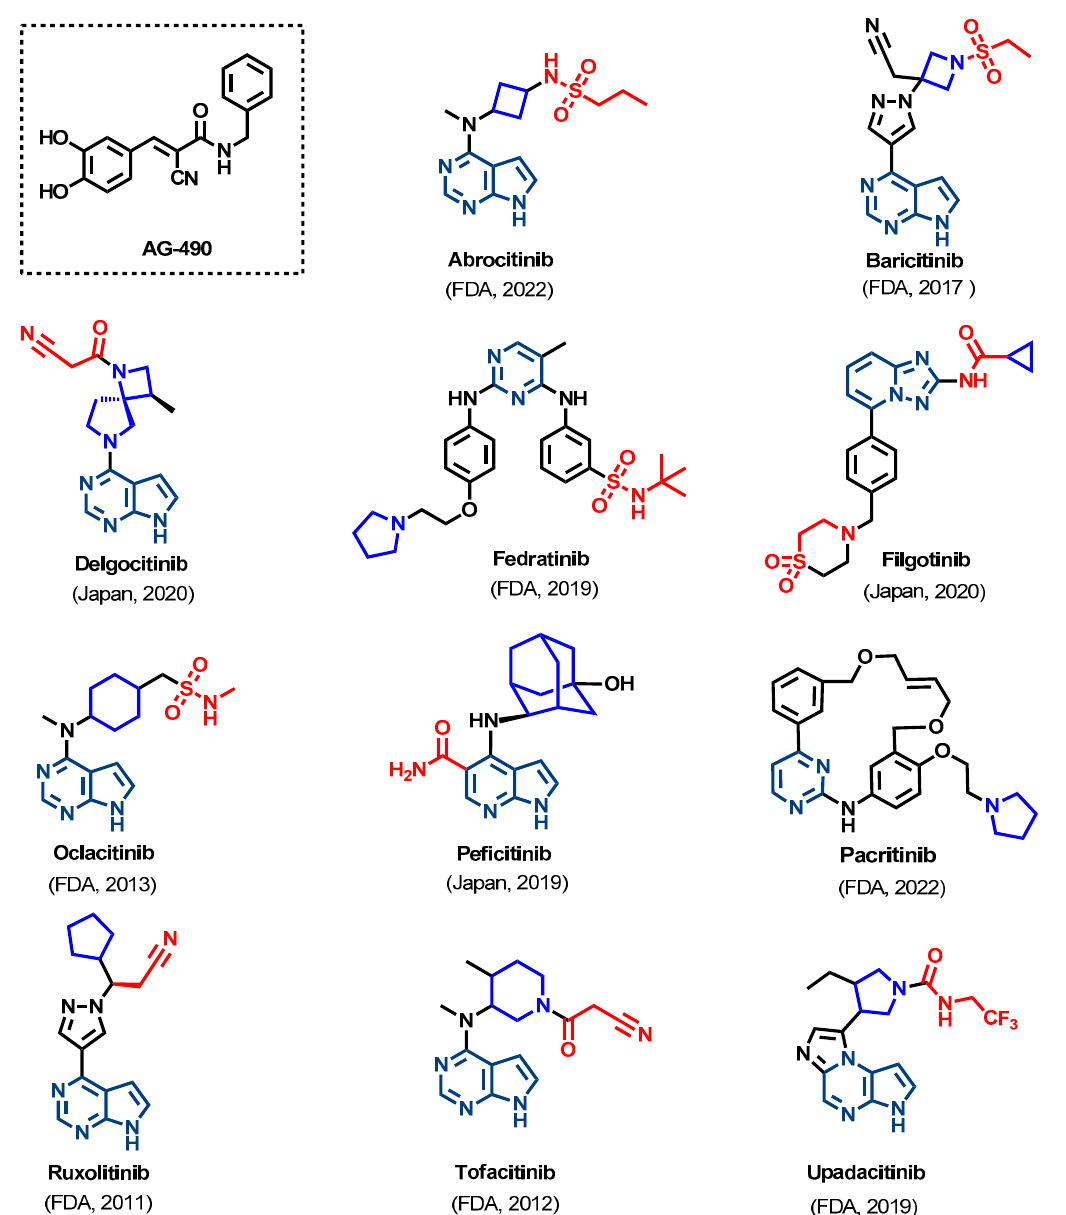
Figure 10. Chemical structure of AG-490 and the globally proven JAK inhibitors with the dates of their first approval.